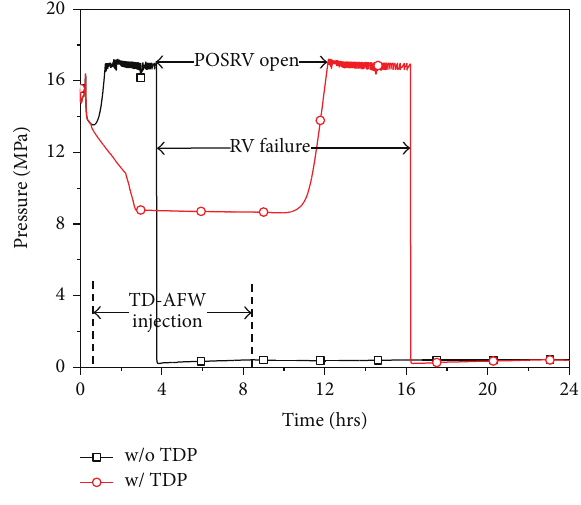
Figure 4: RCS pressure